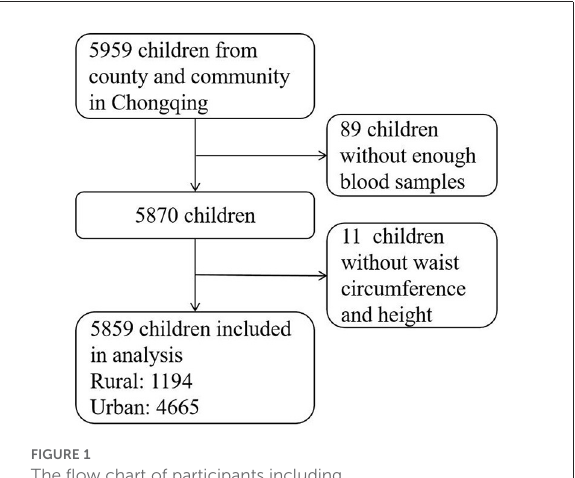
FIGURE1 The flow chart of participants including.